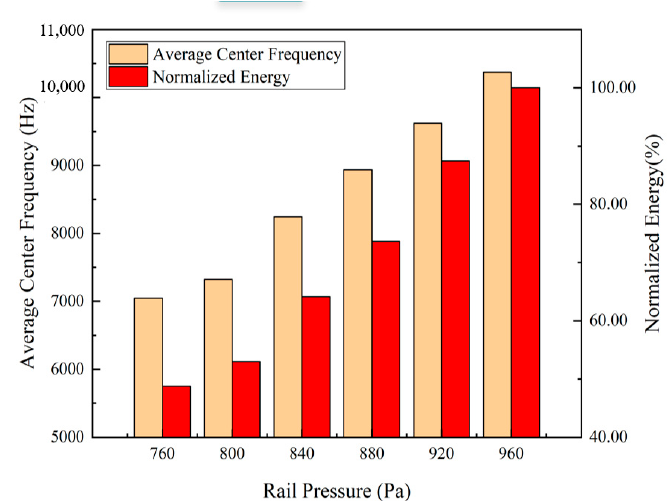
Figure 20. Average center oscillation frequency and the normalized average oscillation energy under di ff erent rail pressures.